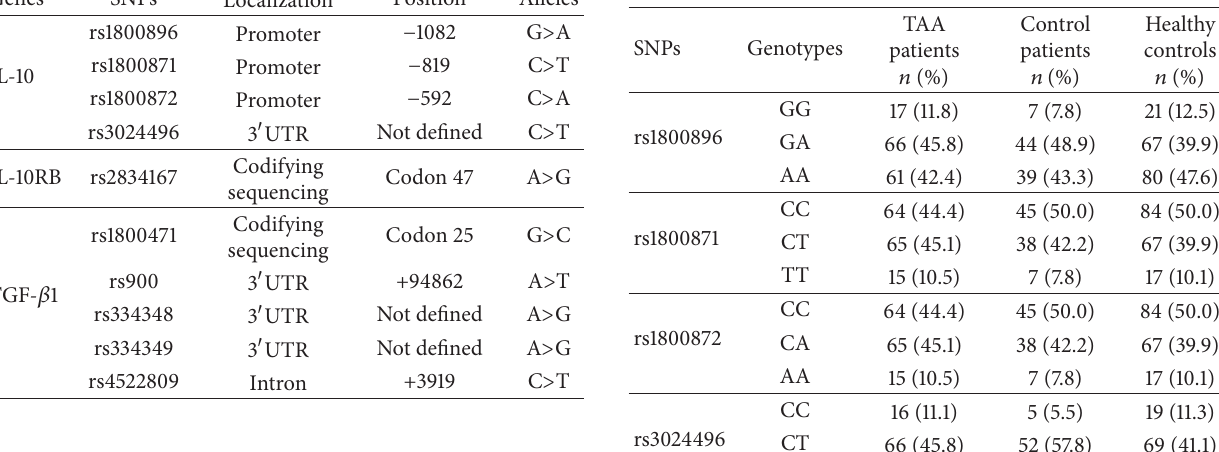
Table 3: Single nucleotide polymorphism frequencies of IL-10 pathway genes in patients affected by sporadic TAA and the two groups of controls subjects ∗